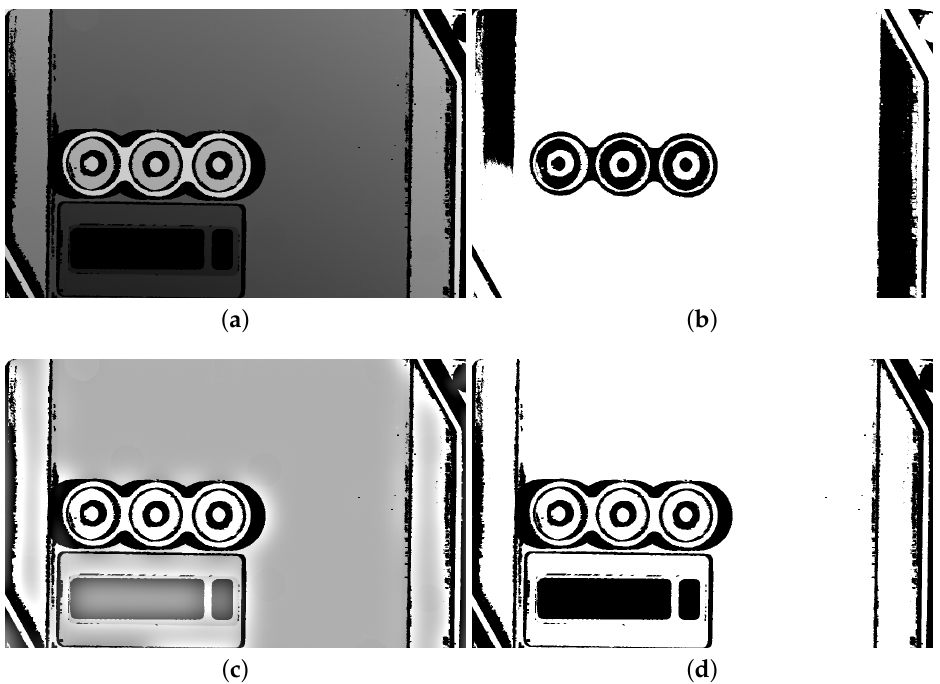
Figure 3. Retinex filter. ( a ) The scanned depth map; ( b ) binarization of the scanned depth map by the IsoData threshold; ( c ) the output from the Retinex filter applied to the scanned depth map; ( d ) binarization of the Retinex filter output by the IsoData threshold.